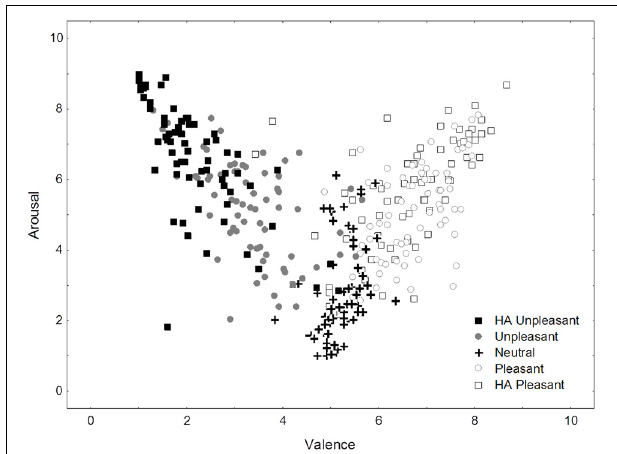
FIGURE 1 | Individual mean valence and arousal ratings for the affective categories presented in this